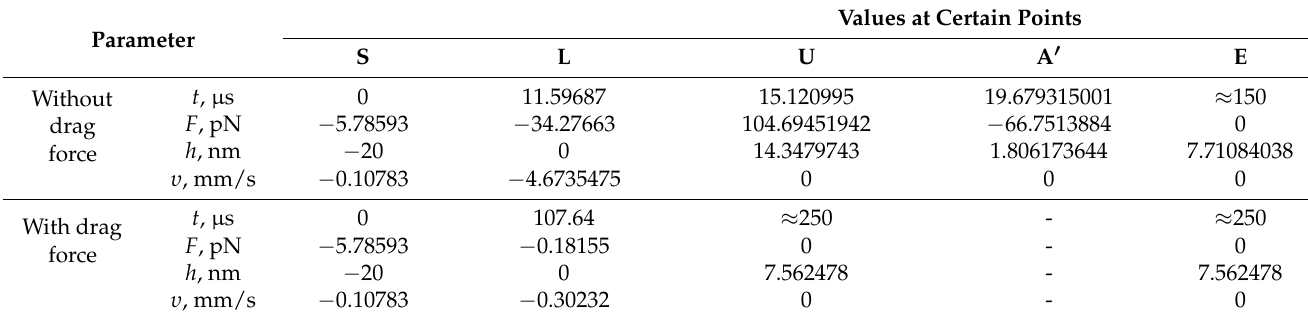
Table 2. Properties of the movement of an erythrocyte during interaction at certain points S-L-U-A (cid:48) -E.